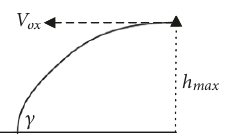
Figure 4: Velocity determination for fixed-wing UAVs.